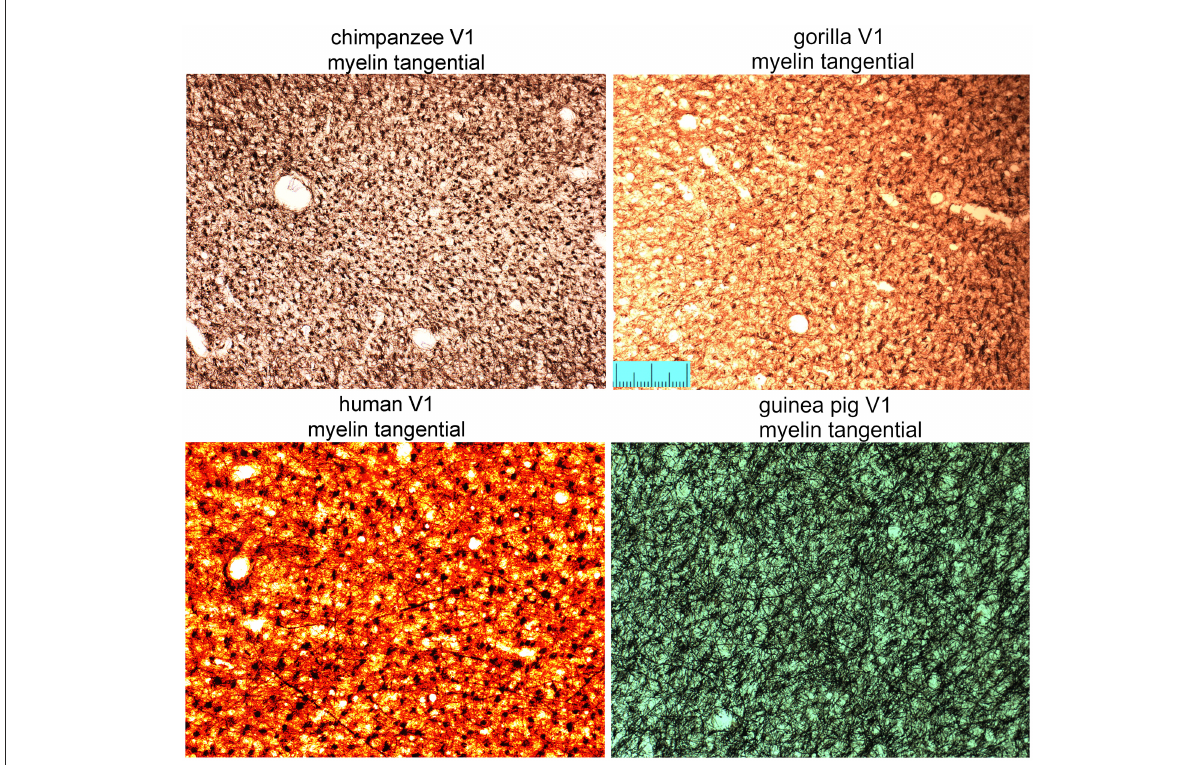
FIGURE7 Tangential sections through layer V of the primary visual area (V1) stained for myelin to show the regularity of bundles of descending fibers in three great apes and the guinea pig. Scale bar is 200 µ m.